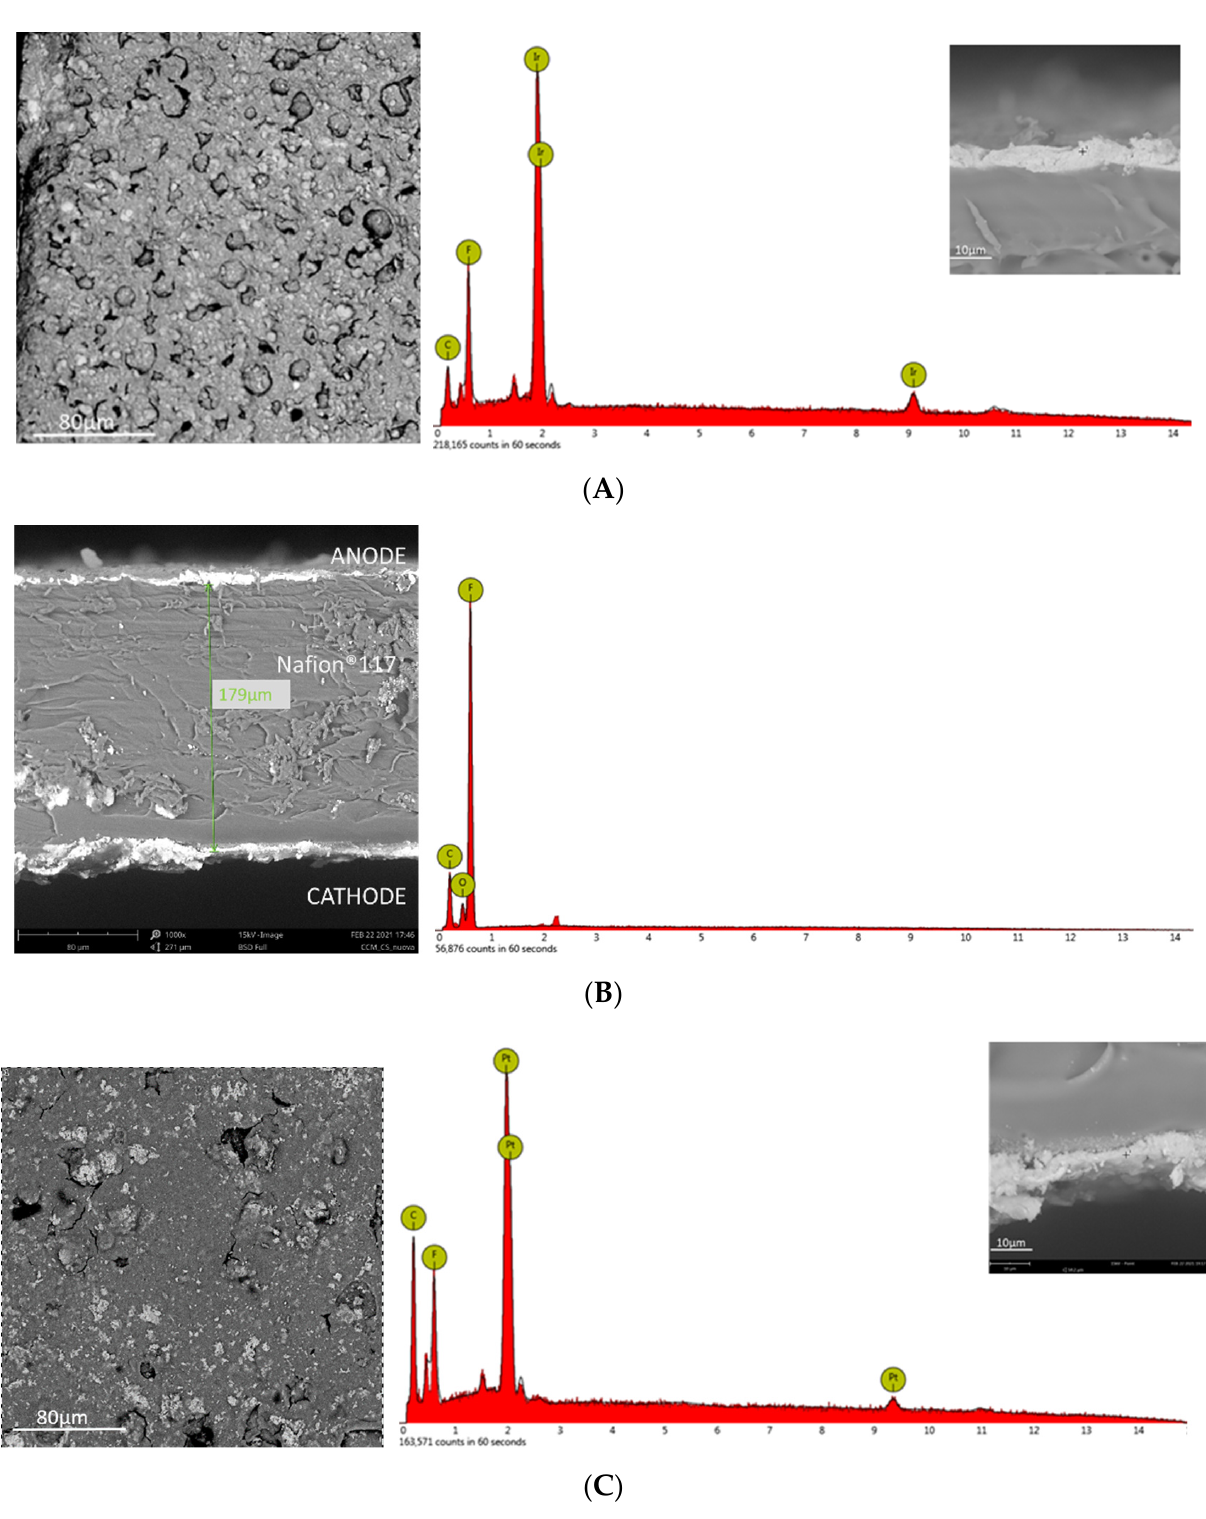
Figure 5. SEM and EDX analysis of the surface at a magnification of 500× and an accelerating voltage of 15 kV for the anode side ( A ) and cathode side ( B ), and cross-section ( C ) of CCM at magnification of 1000× and an accelerating voltage of 15 kV for the Ir-Pt-Nafion™ 117 CCM.